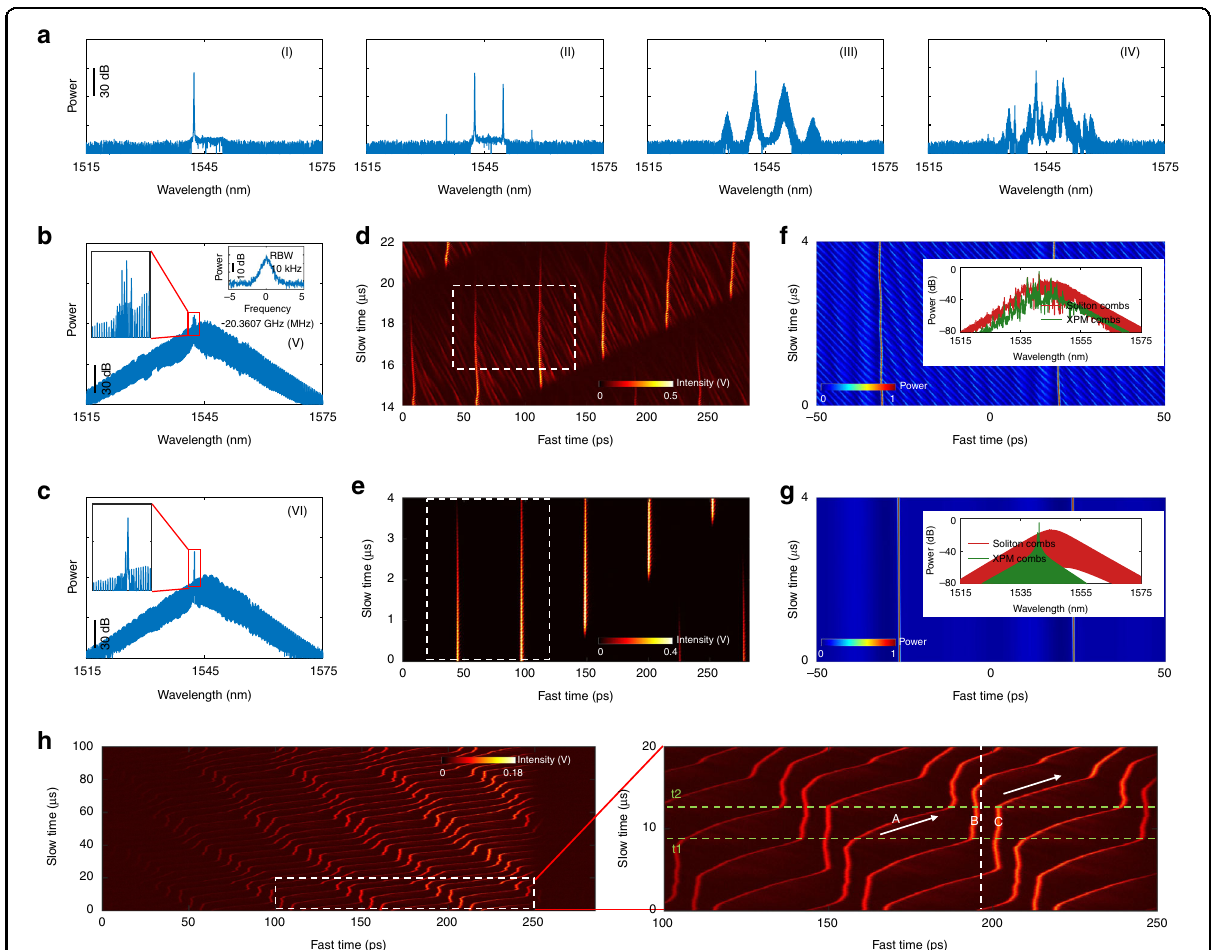
Fig. 4 Dynamics of dissipative soliton in microresonator- fi ltered fi ber lasers. a – c Spectral evolution of different states when the detuning changes from the blue side to the red side. Insets in state V show the enlarged spectra and RF beat note of unstable repetition rate. Inset in state VI shows the enlarged spectra. d , e Real-time dynamics measured by time magni fi er for ( d ) unstable mode-locking and ( e ) stable mode-locking. The white dashed boxes indicate the dynamics in a single roundtrip of the microresonator, which agree well with the simulated results. f , g Simulated dynamics for ( f ) unstable mode-locking and ( g ) stable mode-locking. Insets are the simulated optical spectra. h Soliton Newton ’ s cradle. The right panel is the zooned-in area of the left panel indicated by the white dashed box. The white dashed line in the right panel indicates the retarded time frame of soliton B. The arrowed lines indicate the soliton moving